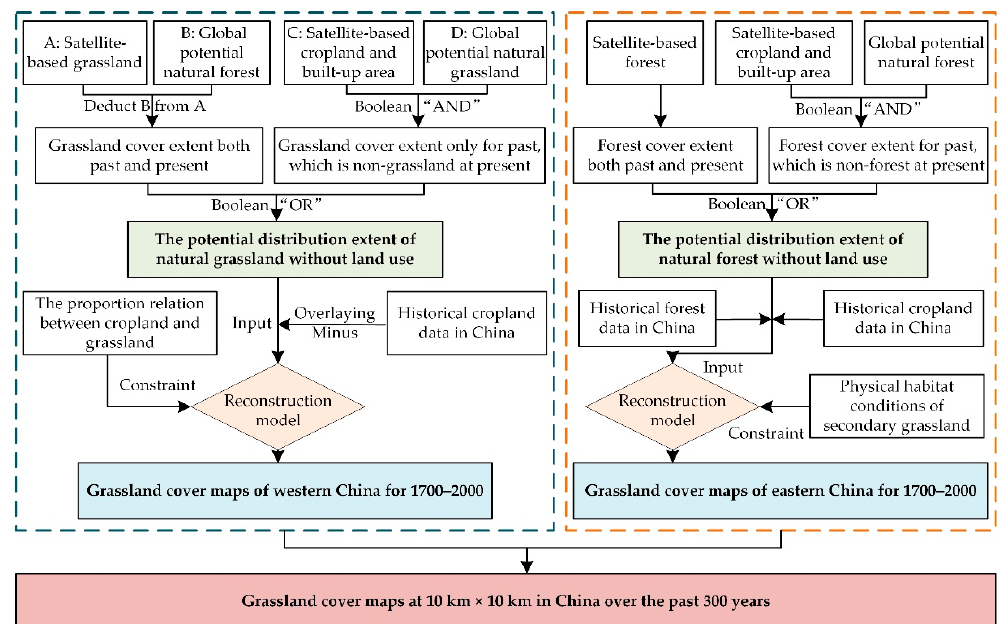
Figure 2. Scheme for reconstructing grassland cover in China from 1700 to 2000.